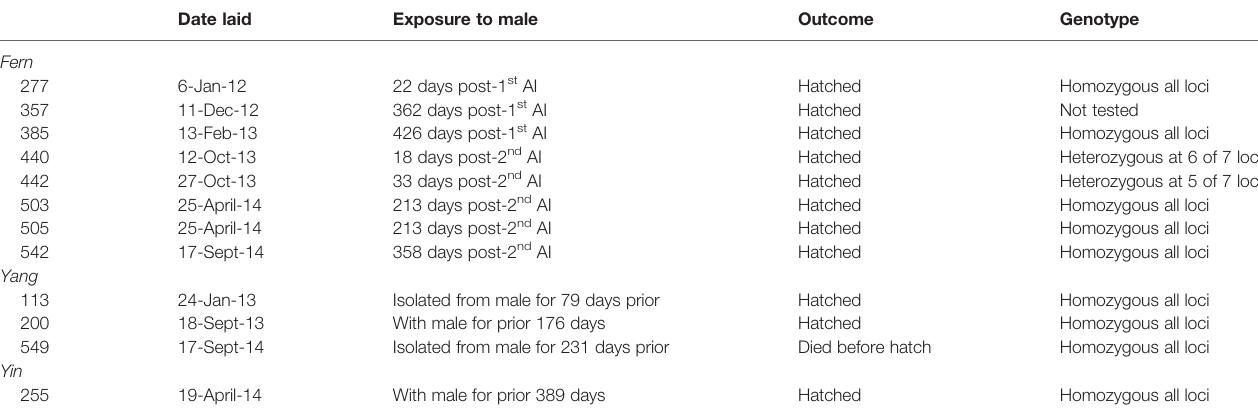
TABLE 1 | Paternity of embryos and hatchlings by dam with days since possible semen exposure. Egg identi fi cation numbers are listed below each dam.